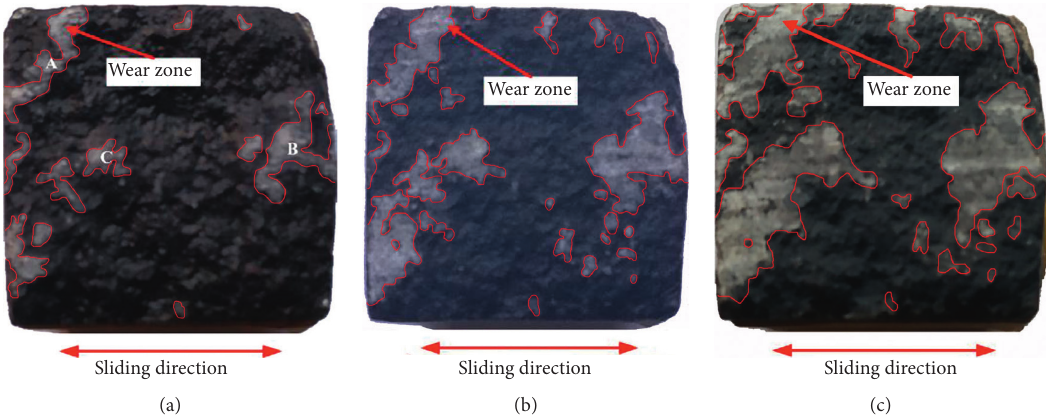
Figure 5: Surface diagrams of the Sandstone Joint after the (a) 1 st cycle, (b) 5 th cycle, and (c) 10 th cycle.